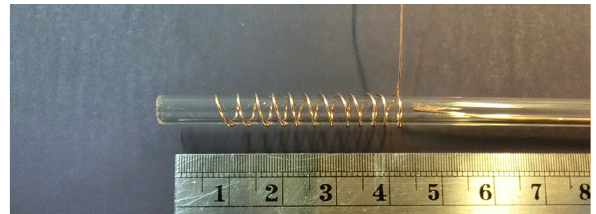
Figure 1. Jet nozzle with tip-ring method (cascade ring).